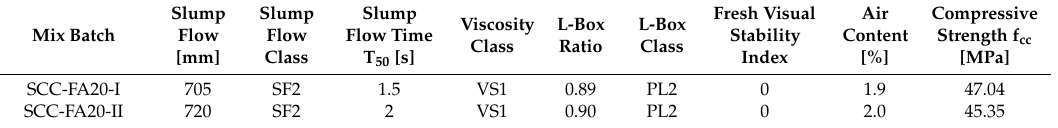
Table 3. Fresh properties and cubic compressive strength test